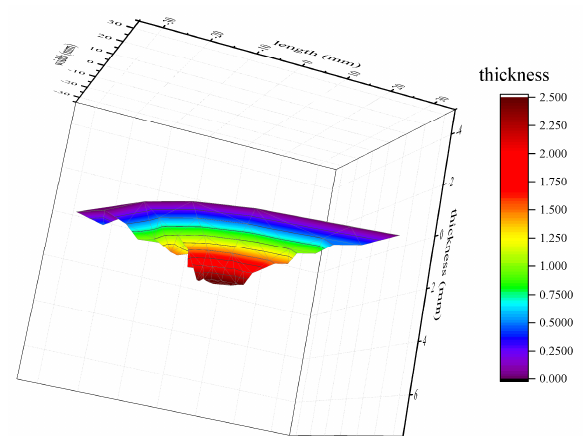
Figure 7. The ablative space of CFRP.